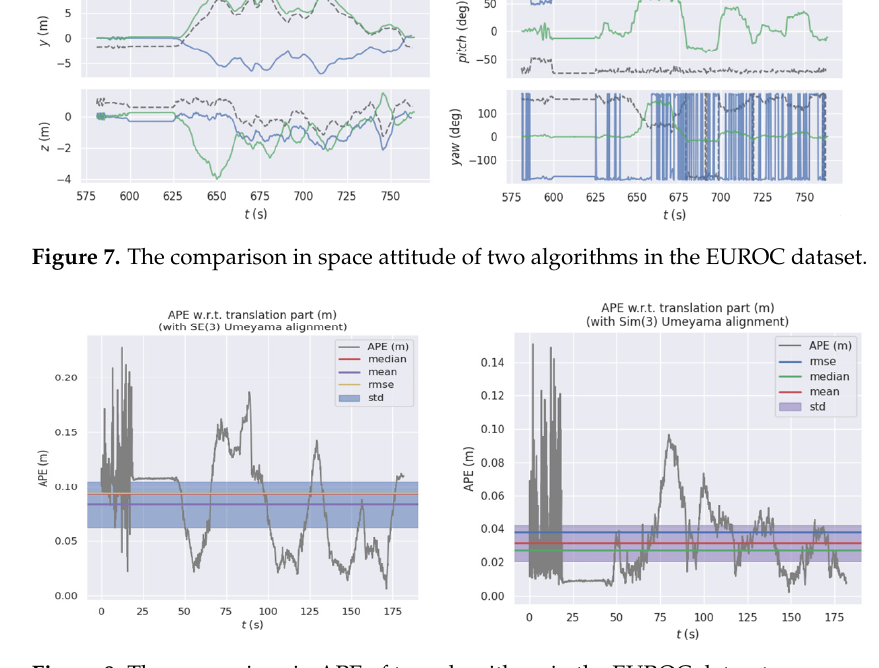
Figure 8. The comparison in APE of two algorithms in the EUROC dataset.